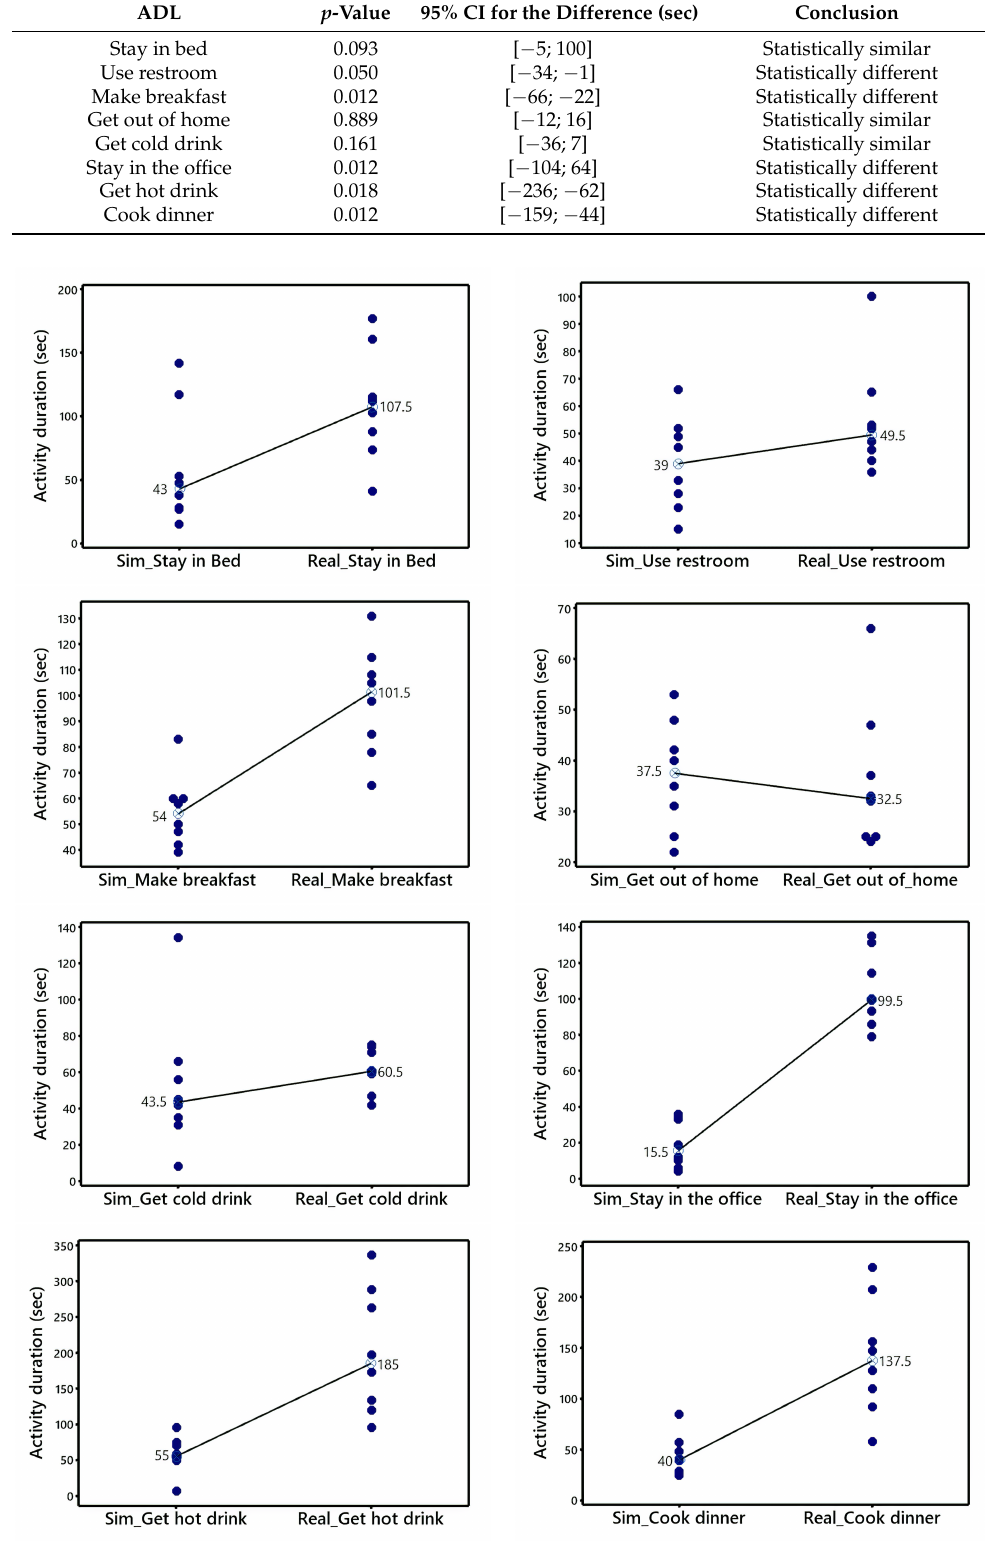
Figure 3. Differences between synthetic and real activity duration. The ADLs in the first row from the left are: Stay in bed and Use restroom ; second row: Make breakfast and Get out of home ; third row: Get cold drink and Stay in the office ; and fourth row: Get hot drink and Cook